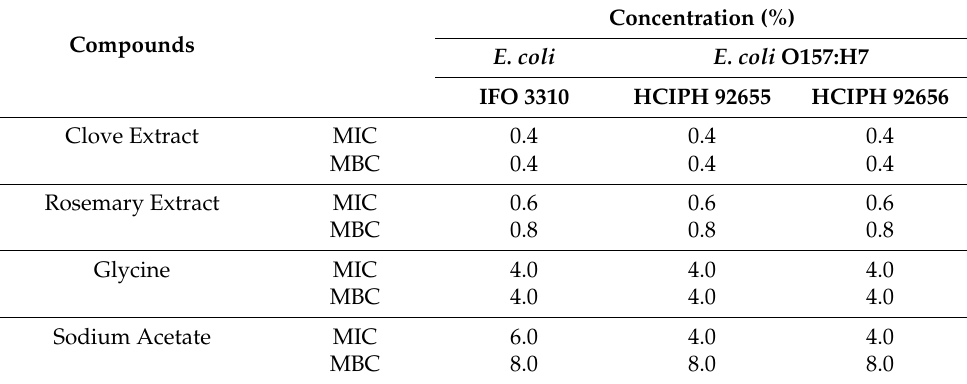
Table 4. Minimum inhibitory concentration (MIC) and minimum bactericidal concentration (MBC) of plant extracts and antimicrobial agents against pathogenic and non-pathogenic E. coli at neutral pH. Concentration (%) Compounds E. coli